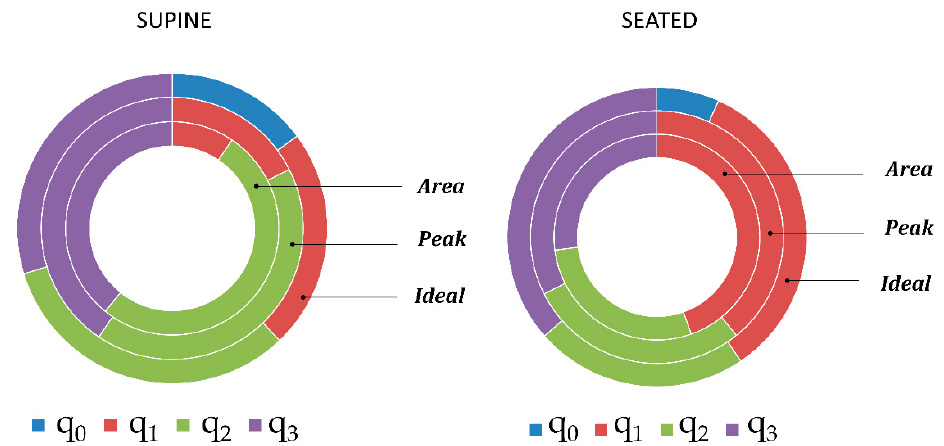
Figure 11. Relative frequencies of quaternion component (q 0 , q 1 , q 2 , q 3 ) selection using Area and Peak methods and of quaternion component selection as Ideal component, in supine and seated position. Each portion of the rings represents the ratio between the number of times that each quaternion component has been selected (by Area and Peak methods or as Ideal component respectively) and the total number of trials (n = 74).